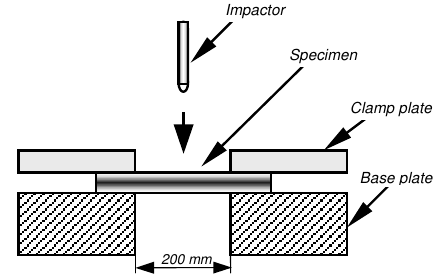
Fig 1. Vertical drop-weight impact test according to Airbus- Norm AIITM